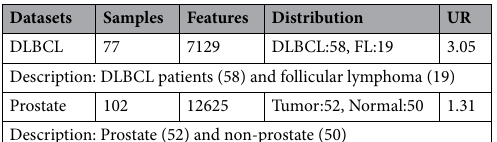
Table 1. Data set description and introduction, UR denotes unbalance rate.